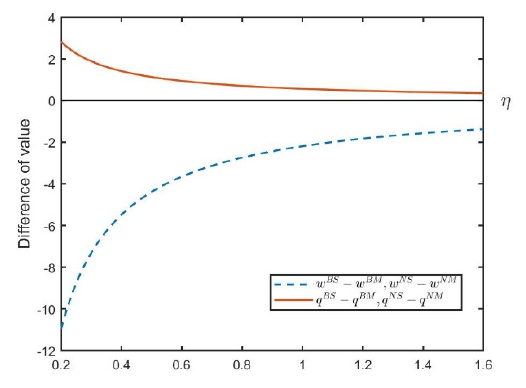
Figure 8. The impact of η on profit difference. ( α = 2.2, ε = 0.2, φ = 0.68). [ w iM ] Lemma 2. ∂ E